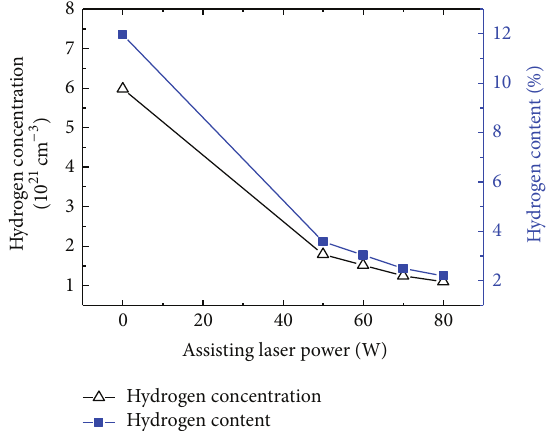
Figure 4: Hydrogen concentration 𝑁 the i-Si films deposited with various assisting laser